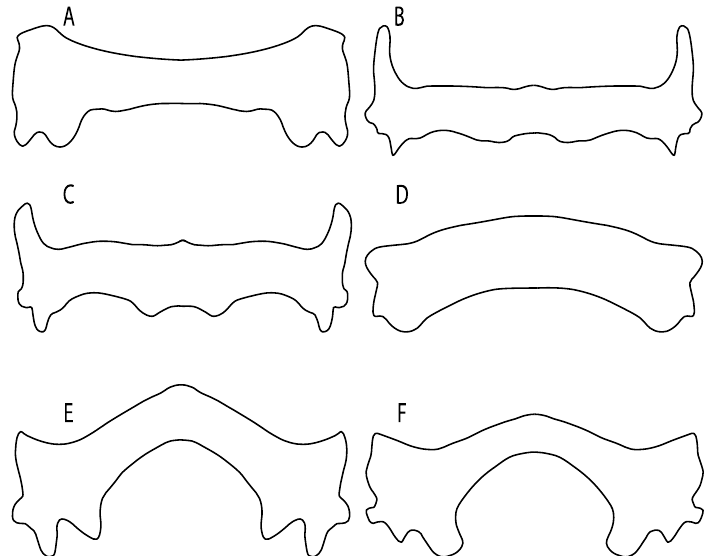
Figure 41. Dorsal view of pelvic girdle. State (0): ( A ) Hemiscyllium ocellatum (AMNH 44128, https://sharksrays.org/ (accessed on 25 March 2020)); ( B ) Rhinobatos productus (CNPE-IBUNAM 17829); ( C ) Glaucostegus granulatus (NHMUK 1926.5.26.5). State (1): ( D ) Heterodontus francisci (AMNH 96795, https://sharksrays.org/ (accessed on 25 March 2020)); ( E ) Zanobatus schoenleinii (MNHN N/C) redrawn and modified from da Silva et al. Text-Figure 4A in [24]; ( F ) Urobatis halleri (CAS 17327) da Silva et al. Text-Figure 8B in [10]. 124. Pelvic girdle: (0) Separated; (1) fused. Modified from Maisey [13] (char, 37), based on observations by Klug et al. [20] (Figure 2), Stumpf et al. [108] and Coates et al. [109]. Current fossil evidence suggests that the separation of two halves, or at least a not very well-mineralized mid-bar of the pelvic girdle, is the basal state across hy- bodontiform-like sharks (Figure 42A,B) (SMNS 10062) (NHMUK PV P 339). Ptr and MLtr (see discussion Maximum Likelihood and Parsimony trees): The pres- ence of two pelvic halves is a shared feature of holocephalians and hybodonts. A fused pelvic girdle, conversely, is a shared feature of elasmobranchs, and due to the uncertainty at the base of the tree recovered, it does not represent a synapomorphy for Elasmobranchii in the current trees.